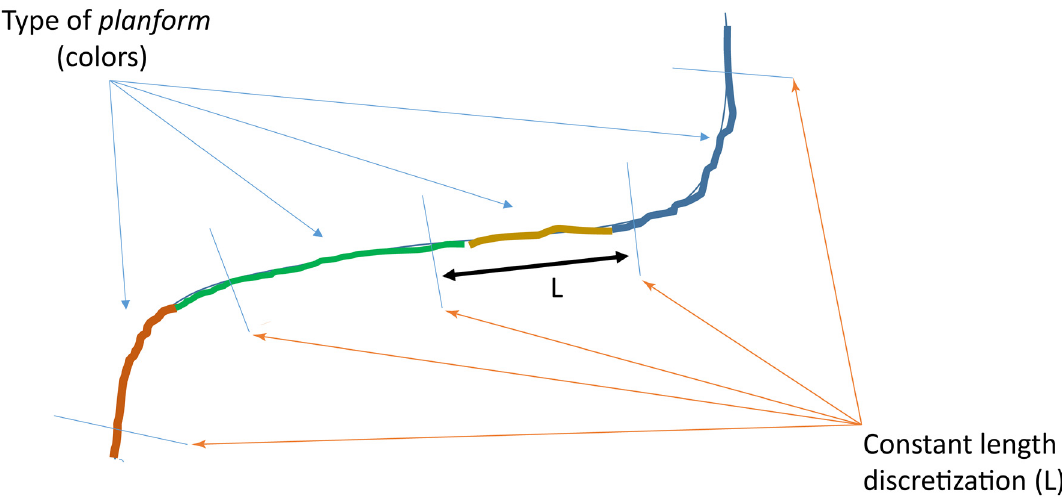
Figure 5. Hypothetical exemplification of why a regular, exogenously imposed discretization is not an appropriate solution.